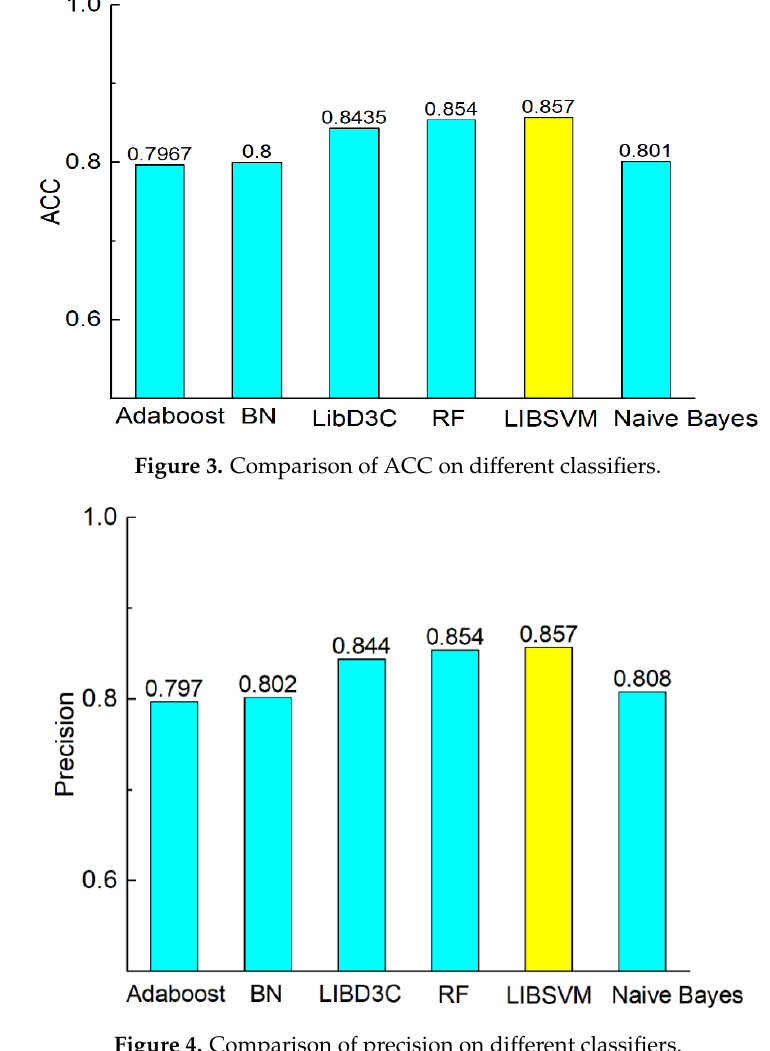
Figure 4. Comparison of precision on different classifiers.